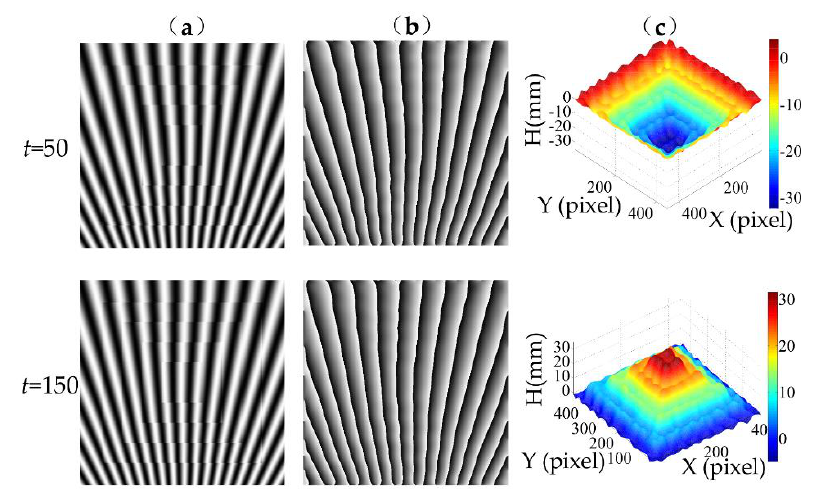
Figure 7. Simulation results of two different moments by conventional FTP. ( a ) Deformed fringe patterns. ( b ) Wrapped phase and ( c ) 3D reconstruction.